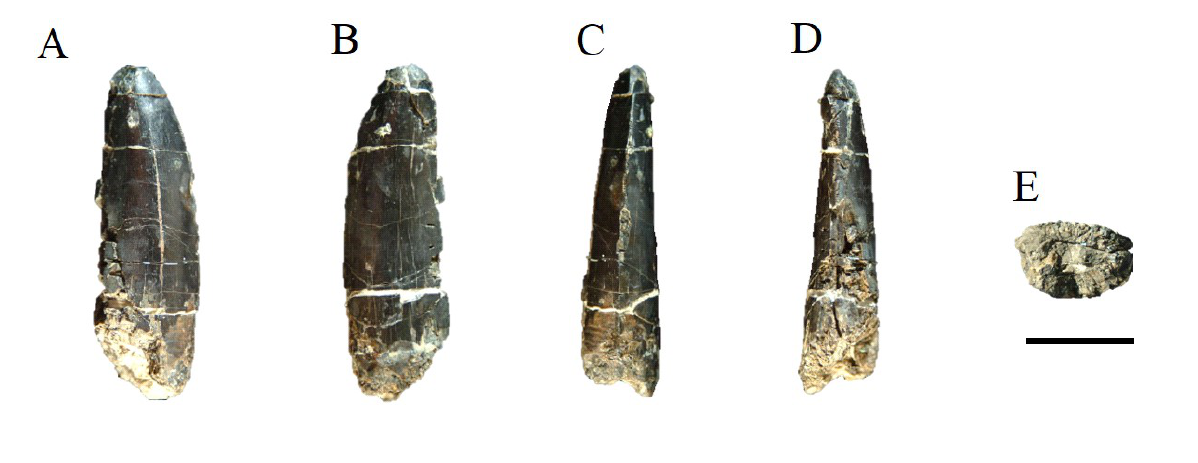
Fig. 1. Remaining photographs of KS 7001, modified from Yun et al. (2007). Large theropod tooth in lingual (A), labial (B), mesial (C), distal (D), and distal (E), and basal (E) views. Scale bar = 20